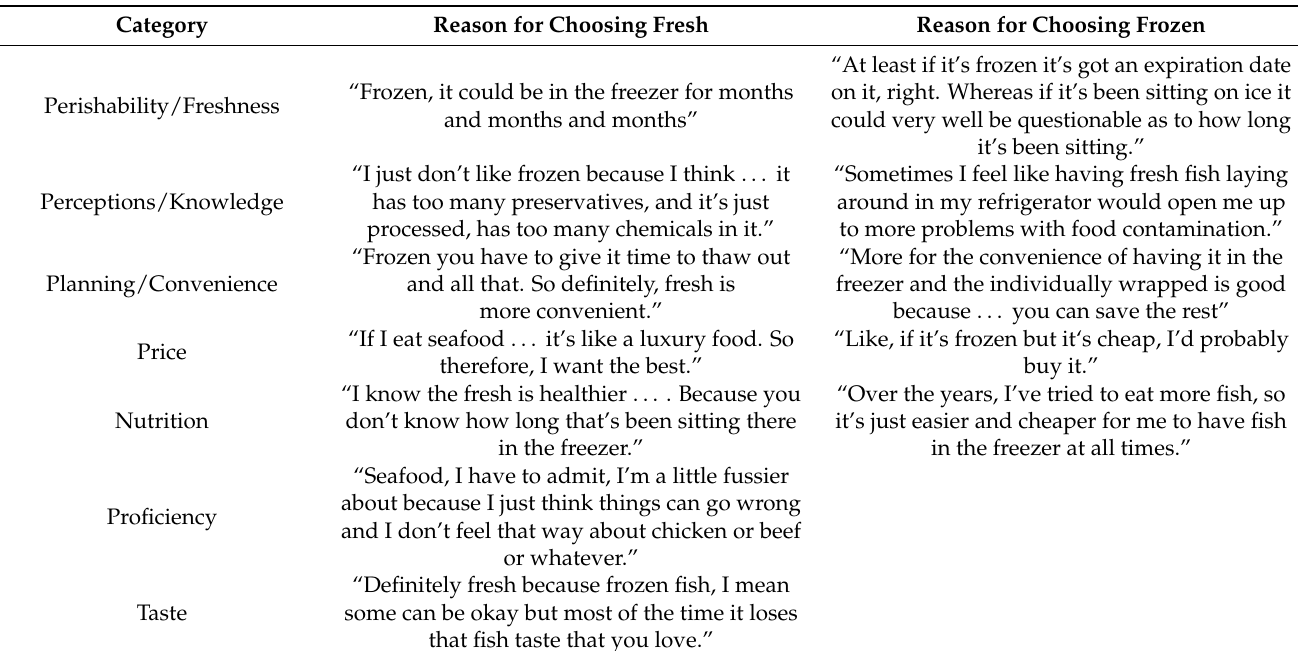
Table 4. Reasons for choosing fresh vs. frozen, when purchasing seafood. Focus group, illustrative quotes. Category